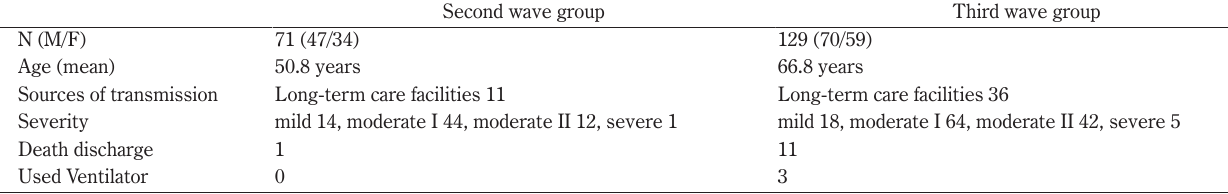
Table 3 Background of Second wave group and Third wave group